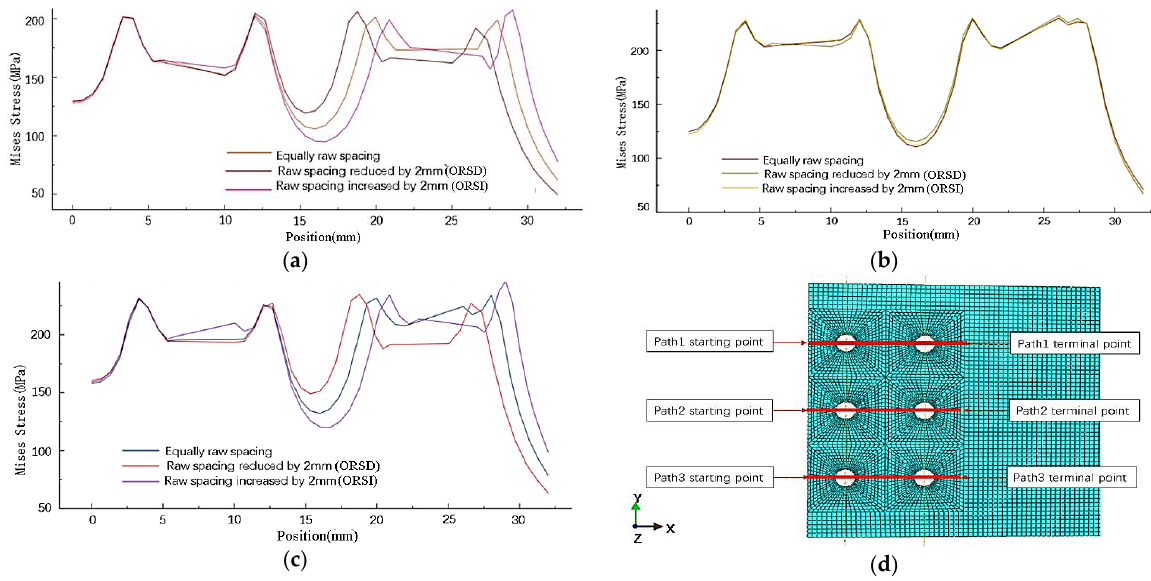
Figure 10. Mises stress distribution in X-direction path of the sheet under different row spacing: ( a ) Mises stress distribution of path1; ( b ) Mises stress distribution of path2; ( c ) Mises stress distribution of path3; ( d ) Path setting of the siding along the stretching